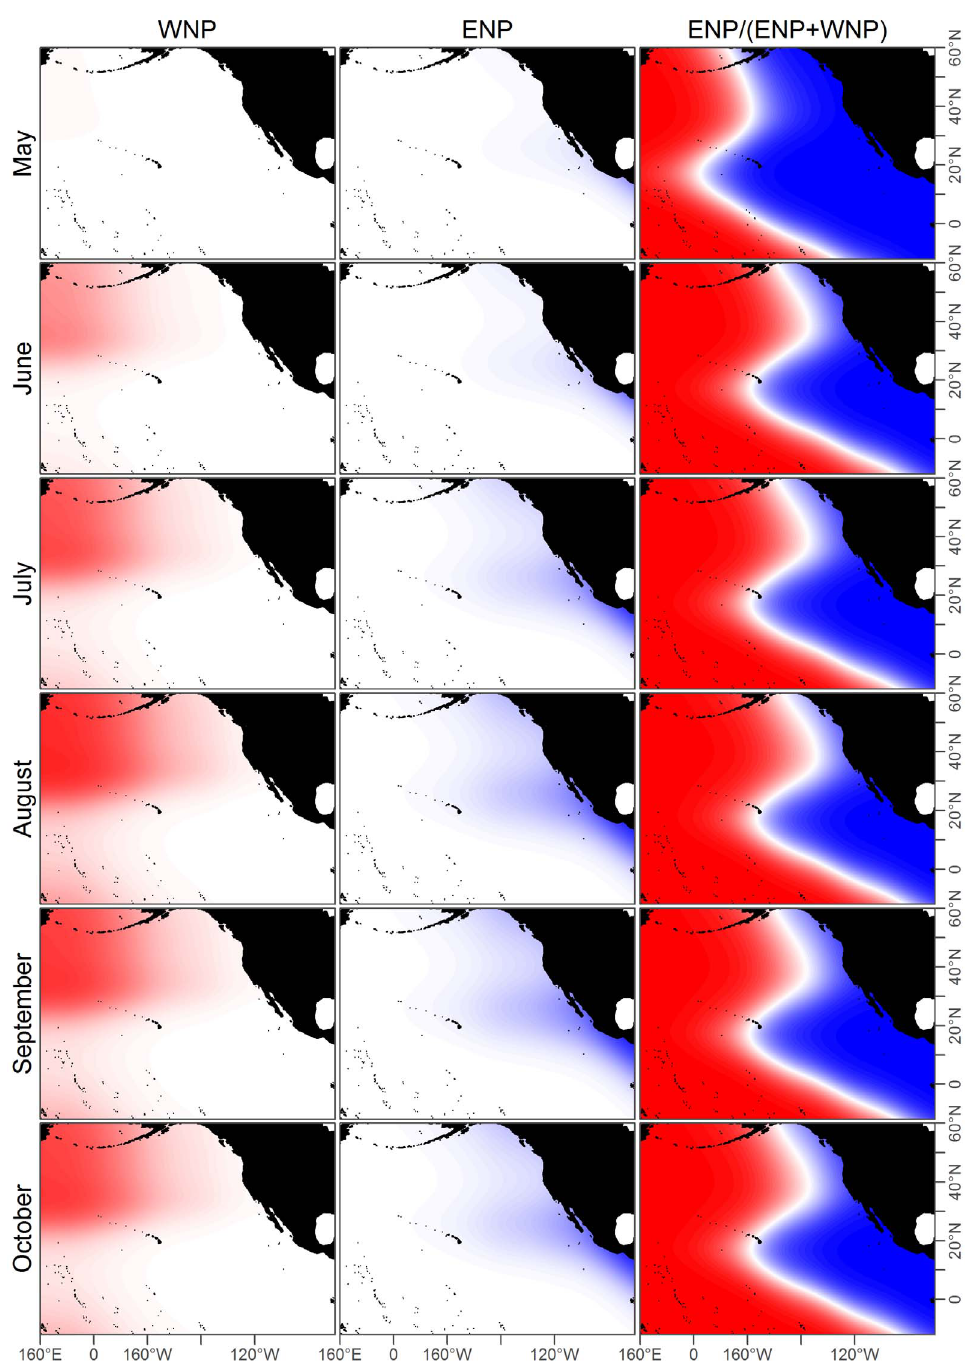
Figure 6. Fits for ENP acoustic, WNP acoustic, and base case prediction models for May-October. These models are fit to the acoustic data in Figures 4 and 5. The third column shows the base case prediction model which is the proportion of ENP to WNP calls, such that red areas correspond to predicted WNP occurrence and blue areas to ENP. The white line denotes where the model predicts an equal chance of observing an ENP or WNP blue whale.